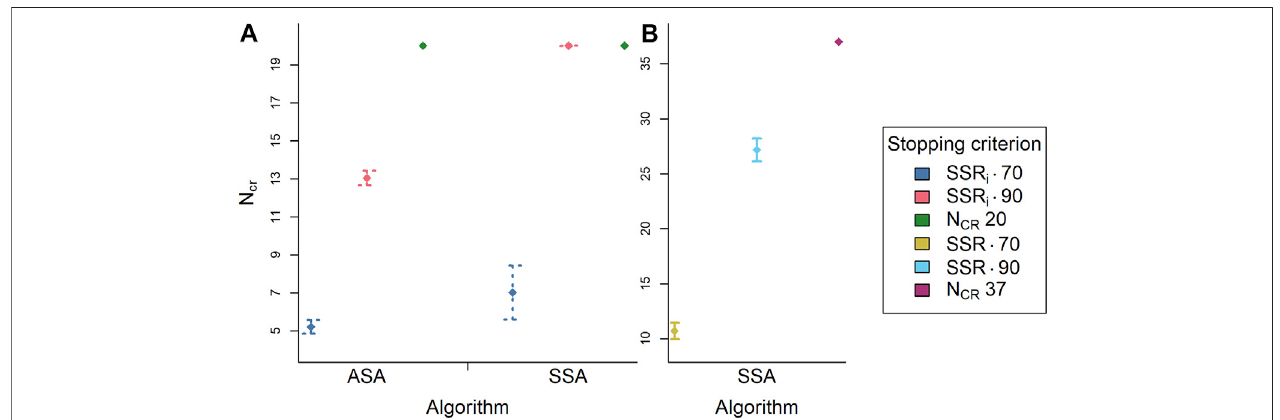
FIGURE 8 | The median number of comparisons per representation (N CR ; n = 20) averaged over simulation repetitions ( n = 1,000) per algorithm (ASA, SSA) and per stopping criterion [colors; (A) SSR i 0.70, SSR i 0.90, N CR 20; (B) SSR 0.70, SSR 0.90, N CR 37] with 95% con fi dence intervals ( n = 1,000). Note: Panel (B) contains only SSA data. ASA = adaptive selection algorithm; SSA = semi-random selection algorithm; SSR i = estimated reliability; N CR = number of comparisons per representation; SSR = rank-order